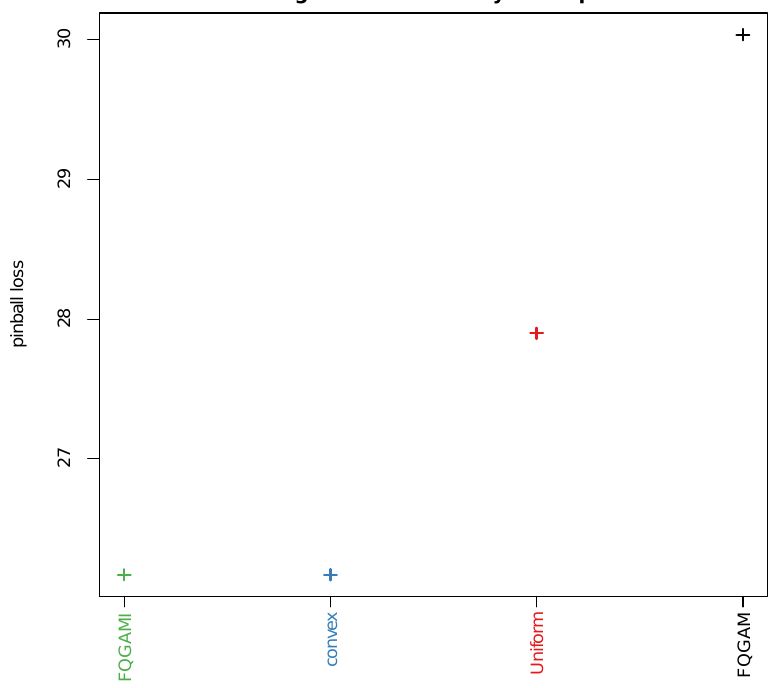
Figure 3. Average loss based on pinball loss suffered by the developed